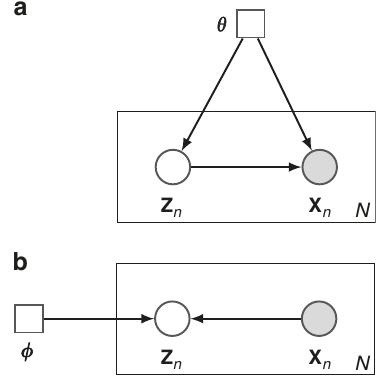
Fig. 6 The scvis directed probabilistic graphical model and the variational approximation of its posterior. Circles represent random variables. Squares represent deterministic parameters. Shaded nodes are observed, and unshaded nodes are hidden. Here we use the plate notation, i.e., nodes inside each box will get repeated when the node is unpacked (the number of repeats is on the bottom right corner of each box). Each node and its parents constitute a family. Given the parents, a random variable is independent of the ancestors. Therefore, the joint distribution of all the random variables is the product of the family conditional distributions. a The generative model to generate data x n , and b the variational approximation q ( z n | x n , ϕ ) to the posterior p ( z n | x n , θ